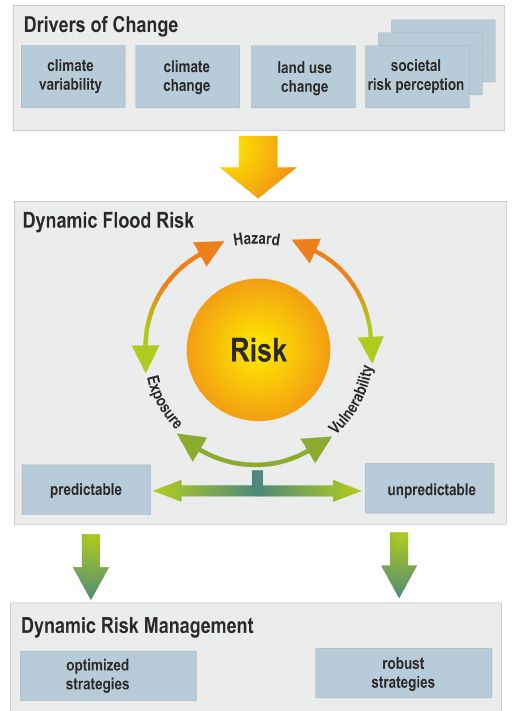
Figure 8. Drivers of flood risk change, dynamic risk and dynamic flood risk